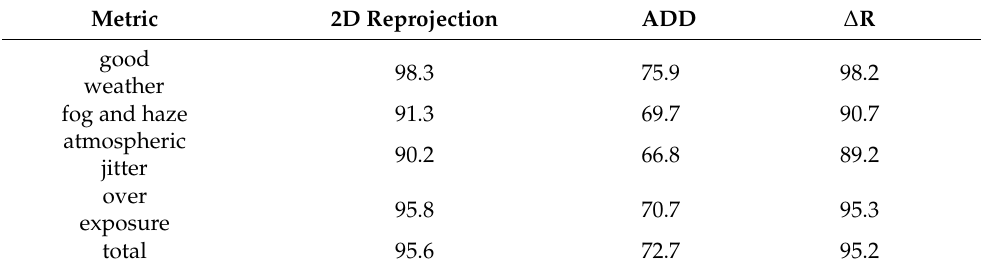
Table 1. Qualitative result of Pose Estimation with Keypoints and Structures (PEKS) on APE dataset under different